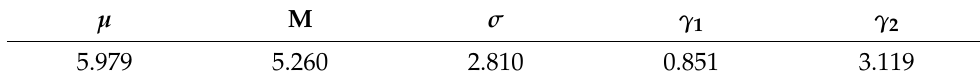
Table 2. Descriptive statistics of survival times of growth hormone medication.